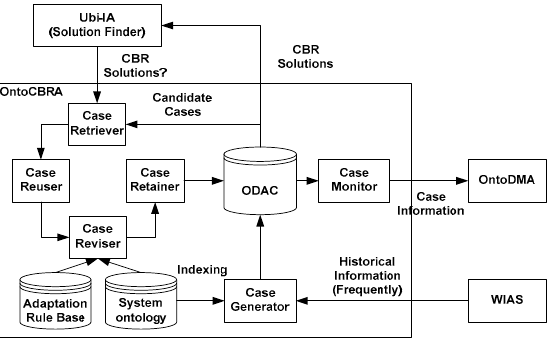
Figure 7. Framework of the proposed system.